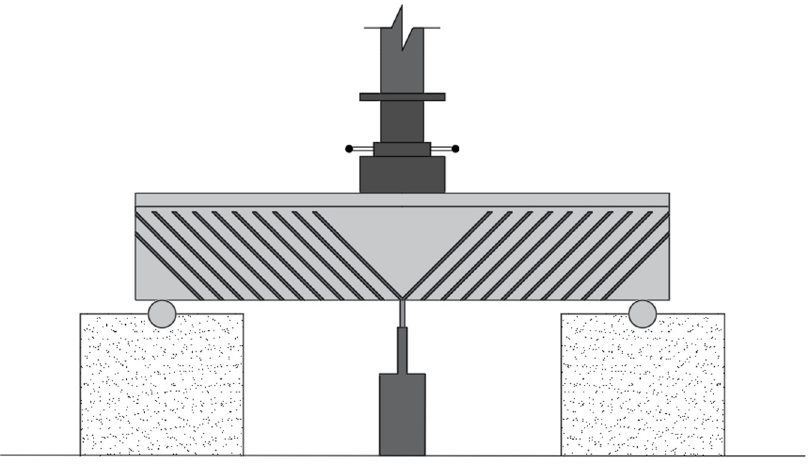
Figure 4. Test Setup. Figure 4. Test